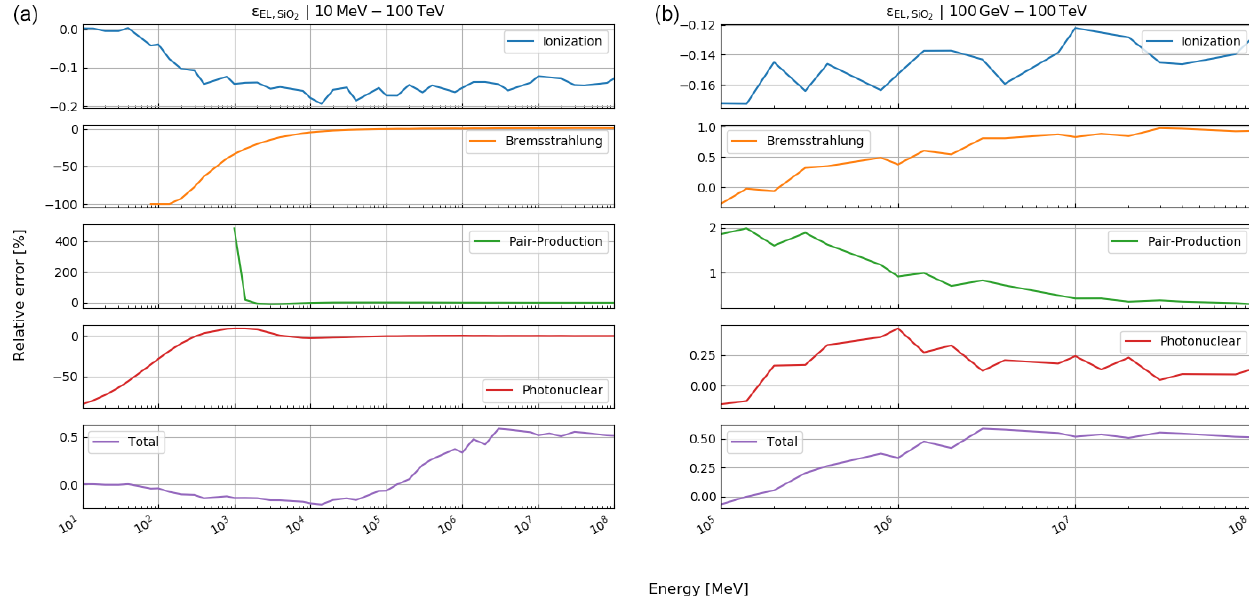
Figure E11. Relative error of our energy loss calculations compared to the tabulated values from Groom et al. (2001) for silicon dioxide (quartz) in the energy ranges (a) 10MeV–100TeV and (b) 100GeV–100TeV.